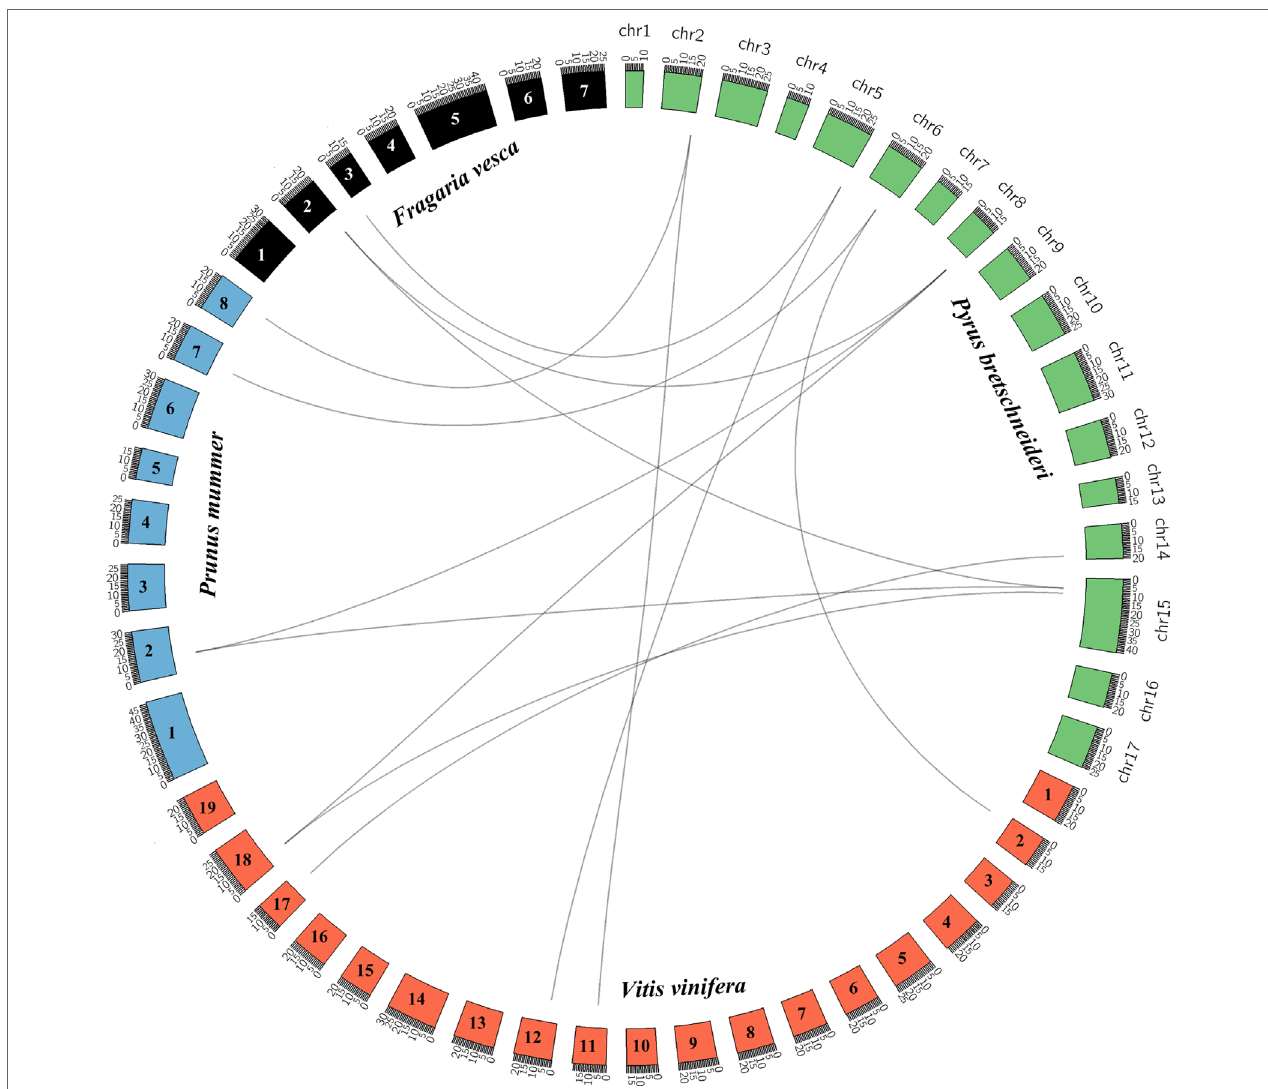
FIGURE 2 | Interspecies collinearity analysis of KNOX regions across among Pyrus bretschneideri (pear) and Prunus mume (mei), Vitis vinifera (grape), and Fragaria vesca